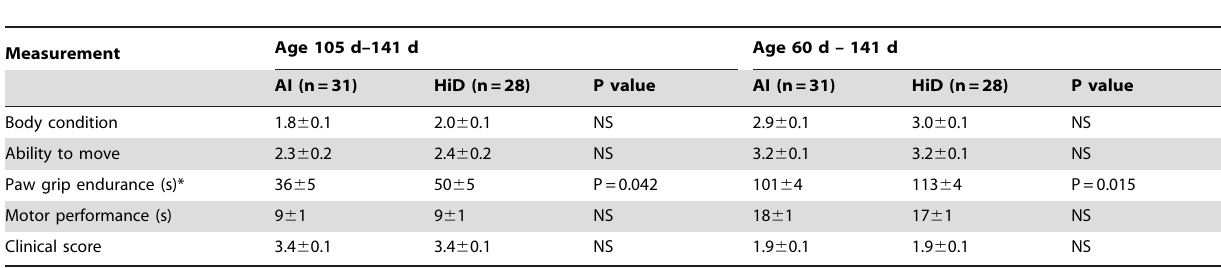
Table 3. Body condition, functional outcomes and clinical score between the diet groups in G93A mice.